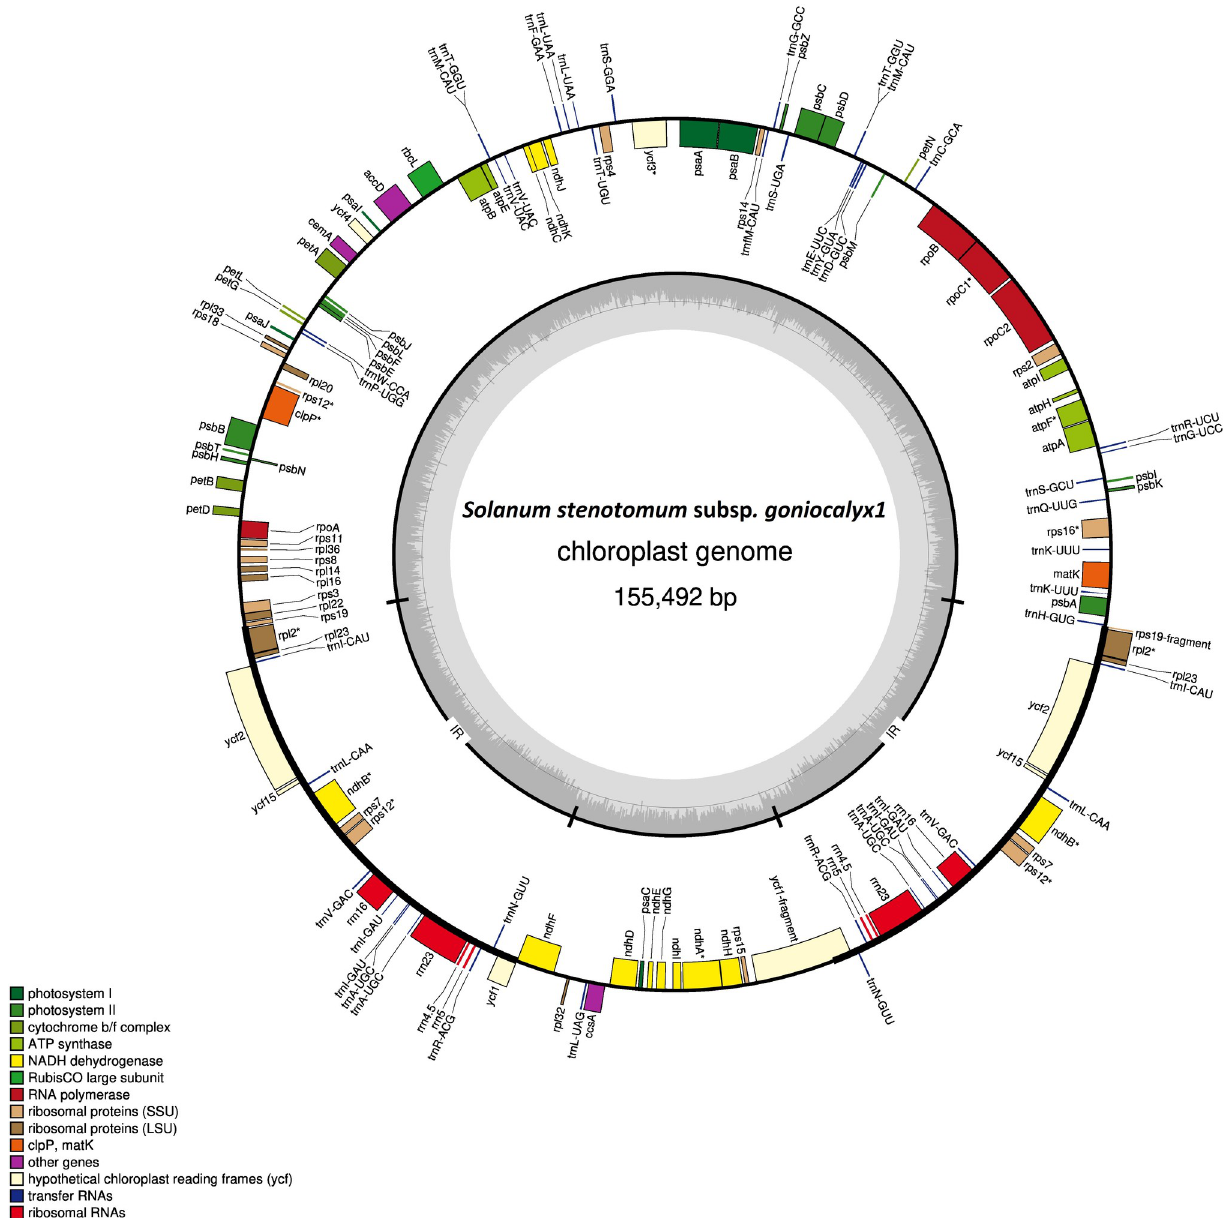
Fig 1. Gene structure of the Solanum stenotomum subsp. goniocalyx 1 plastome. Structure and gene content of the GON1 plastome. A panel of 13 potato plastomes all have similar gene content and structure. Genes that lie outside the circle are transcribed clockwise, genes inside the circle are transcribed counter-clockwise. The inner circle represents GC